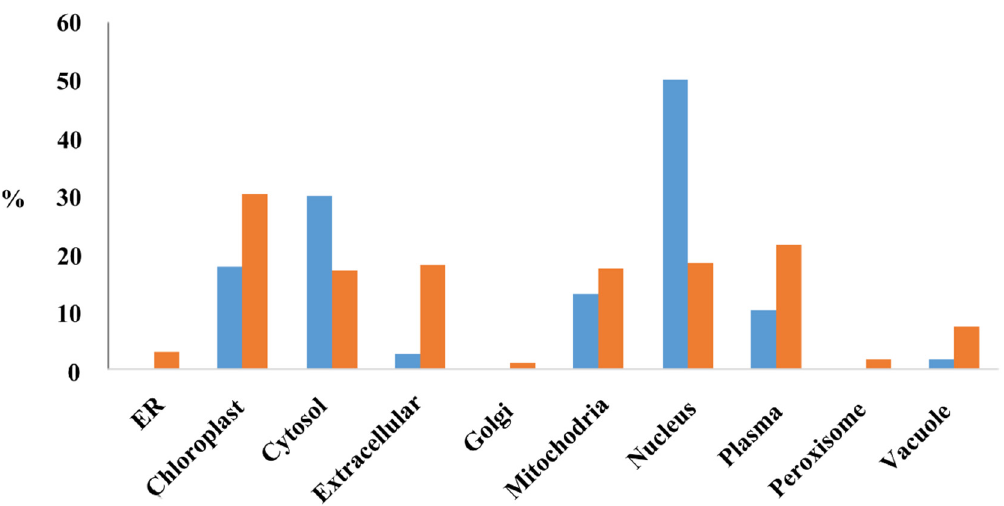
Figure 6. The subcellular localization of proteins encoded by MEGs and PEGs. Y-axis stands for the percentage of proteins located in each organelle. Blue, proteins encoded by PEGs; Orange, proteins encoded by MEGs.